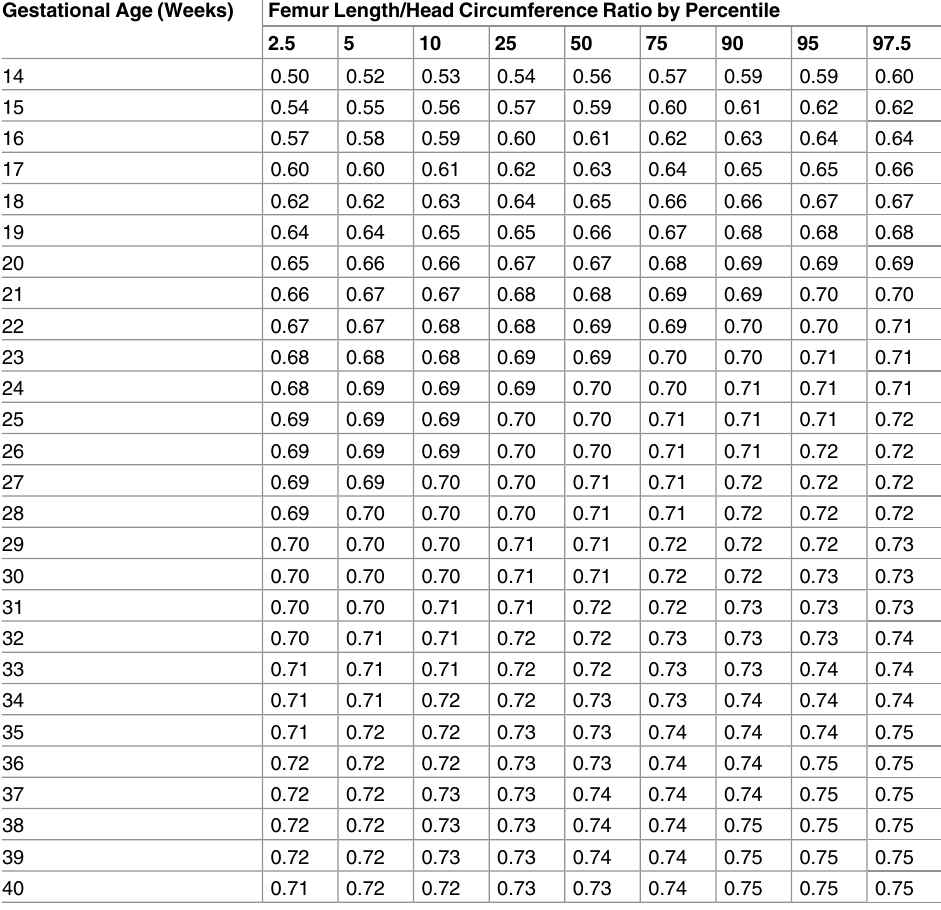
Table 12. Growth chart for fetal femur length/head circumferenceratio. Gestational Age